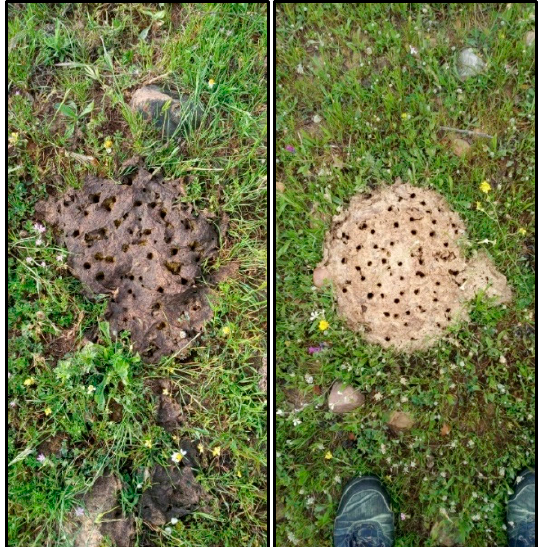
Figure 2. Marking of individual droppings to avoid double counting: fresh dung ( left ) and dry dung ( right ).